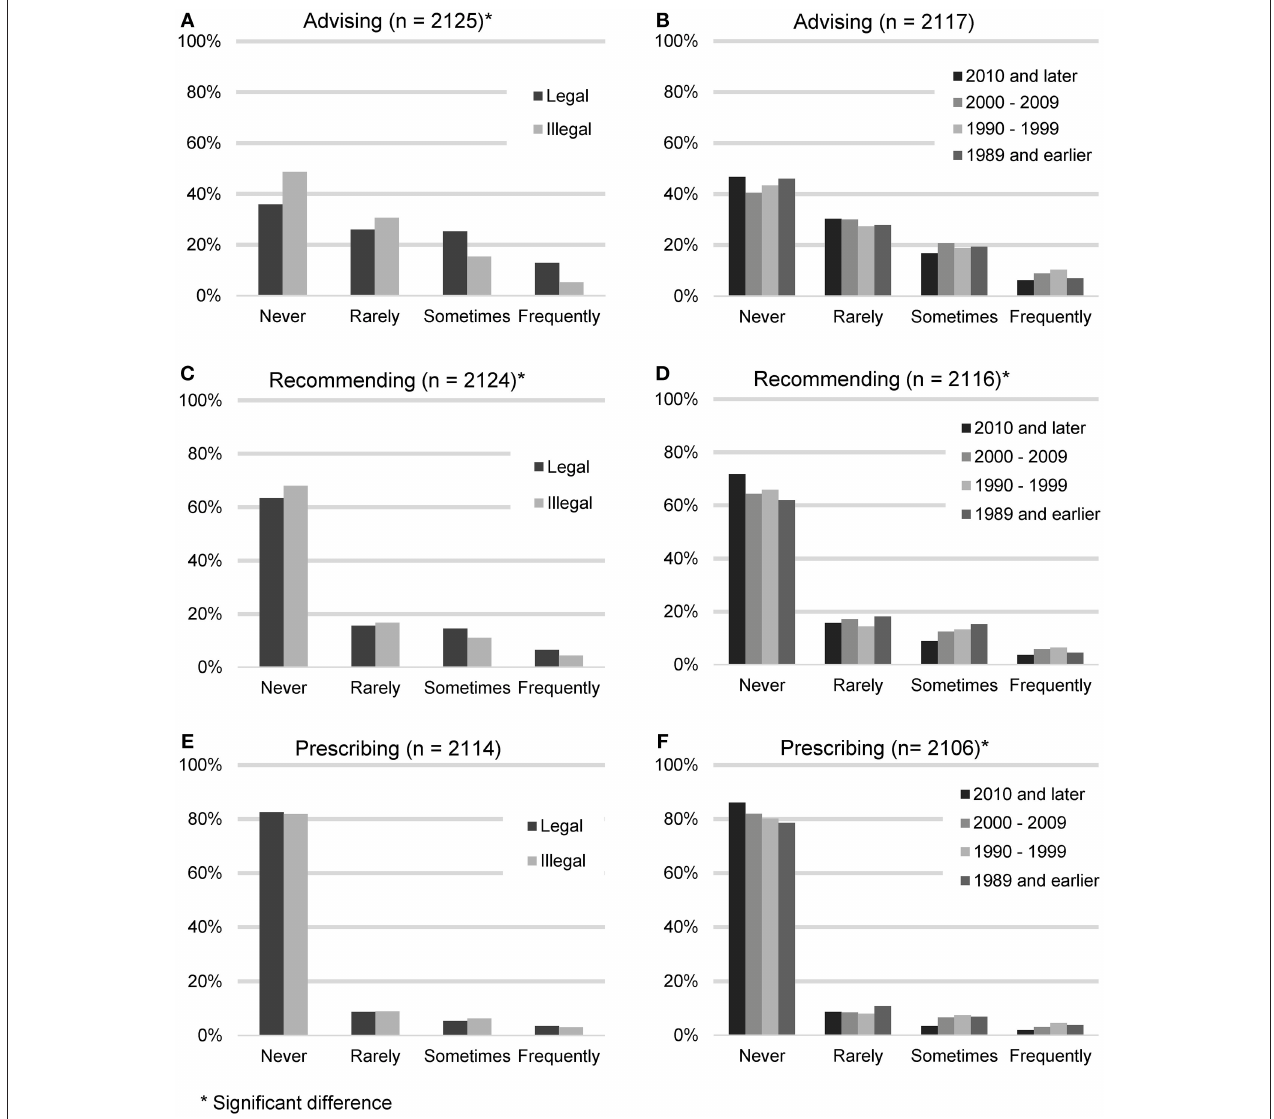
FIGURE 2 | Reported frequency of advising about, recommending, and prescribing CBD products, based on the legal status of recreational marijuana in participants’ state of practice (A,C,E) and participants’ year of graduation (B,D,F)